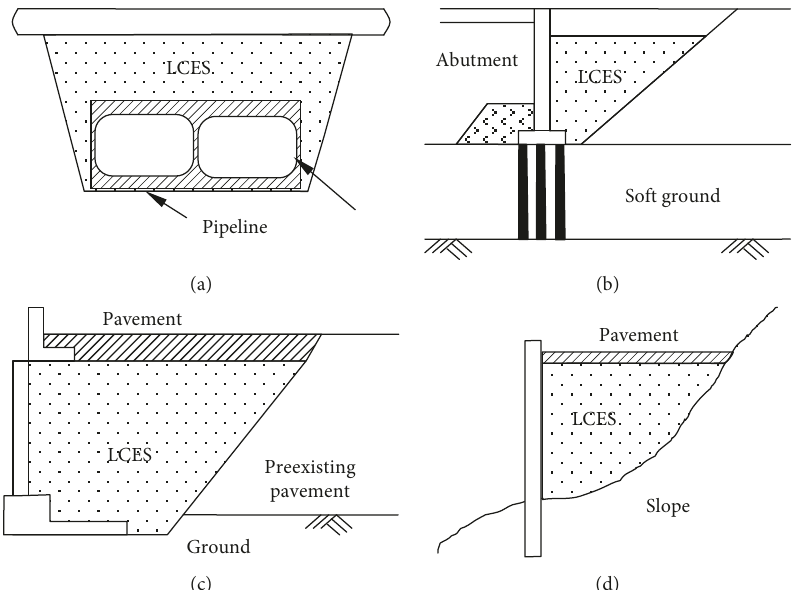
Figure 1: The engineering applications of LCES. (a) Pipeline backfill. (b) Solvent of bridge head jump. (c) Road widening. (d) Slope